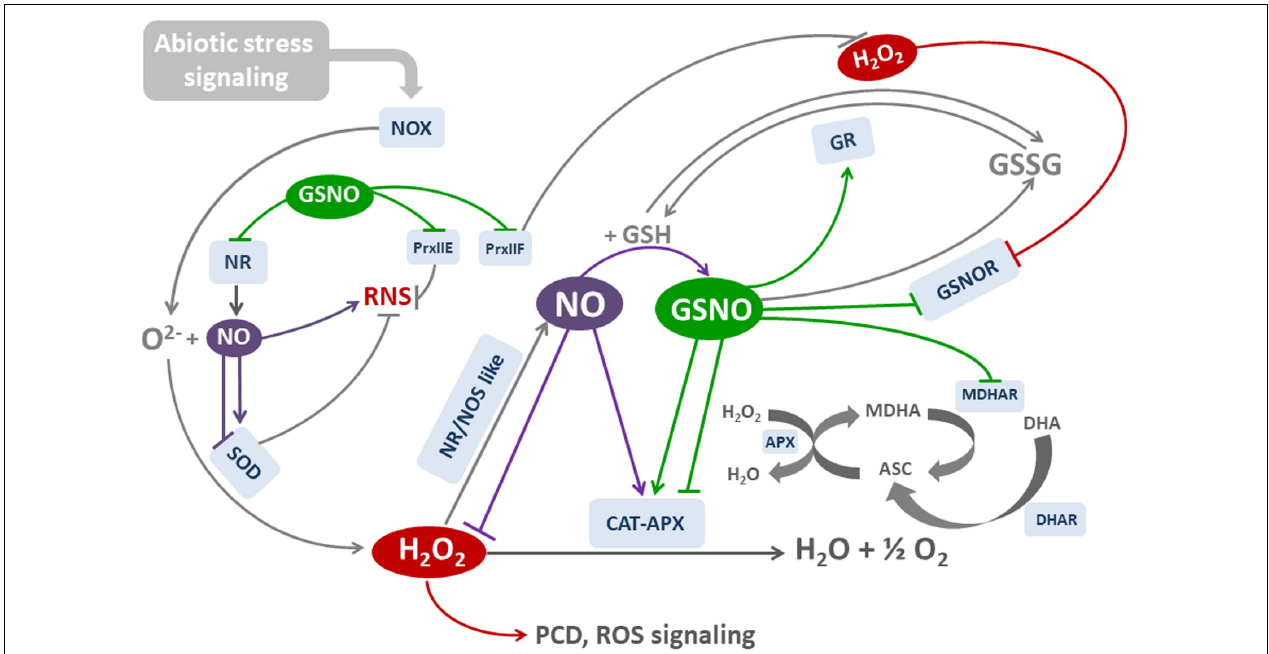
FIGURE 3 | Molecules and mechanisms involved in NO-mediated redox balance. H 2 O 2 is generated mainly by NOX and SOD as a response to (a)biotic stress. APX and CAT are the main H 2 O 2 -degrading enzymes. NO is increased by H 2 O 2 through the induction of NR/NOS-like activities, and may scavenge ROS or induce both the transcription and activity of SOD, CAT, and APX. In parallel, NO is combined with GSH to form nitrosoglutathione GSNO. GSNO regulates many enzymatic activities by the posttranslational modification of cysteine residues through S-Nitrosylation. NOX and CAT activities are inhibited by S-nitrosylation, whereas APX is either activated or inhibited by S-nitrosylation. NO also inhibits APX by binding to heme group. GSNO is degraded by GSNOR, which could be inhibited by H 2 O 2 and S-nitrosylation.NR could be inhibited by S-nitrosylation. GR reduces GSSG to GSH, and it is activated by S-nitrosylation. Ascorbate (ASC) is a cofactor of APX. Reduced ASC is generated by MDHAR and DHAR, using GSH as electron donor. Both enzymes are inhibited by S-nitrosylation. Reactive Nitrogen Species (RNS) may be originated by NO and O •− 2 reaction. SOD regulate RNS dismutating O •− 2 . Peroxiredoxins (Prx) reduce both ROS AND RNS. RNS are degraded by PrxIIe, and H 2 O 2 by PrxIIF. Both enzymes are inhibited by S-nitrosylation. Red lines: H 2 O 2 -regulated reactions. Purple lines: NO-regulated reactions. Green lines: GSNO-regulated reactions.